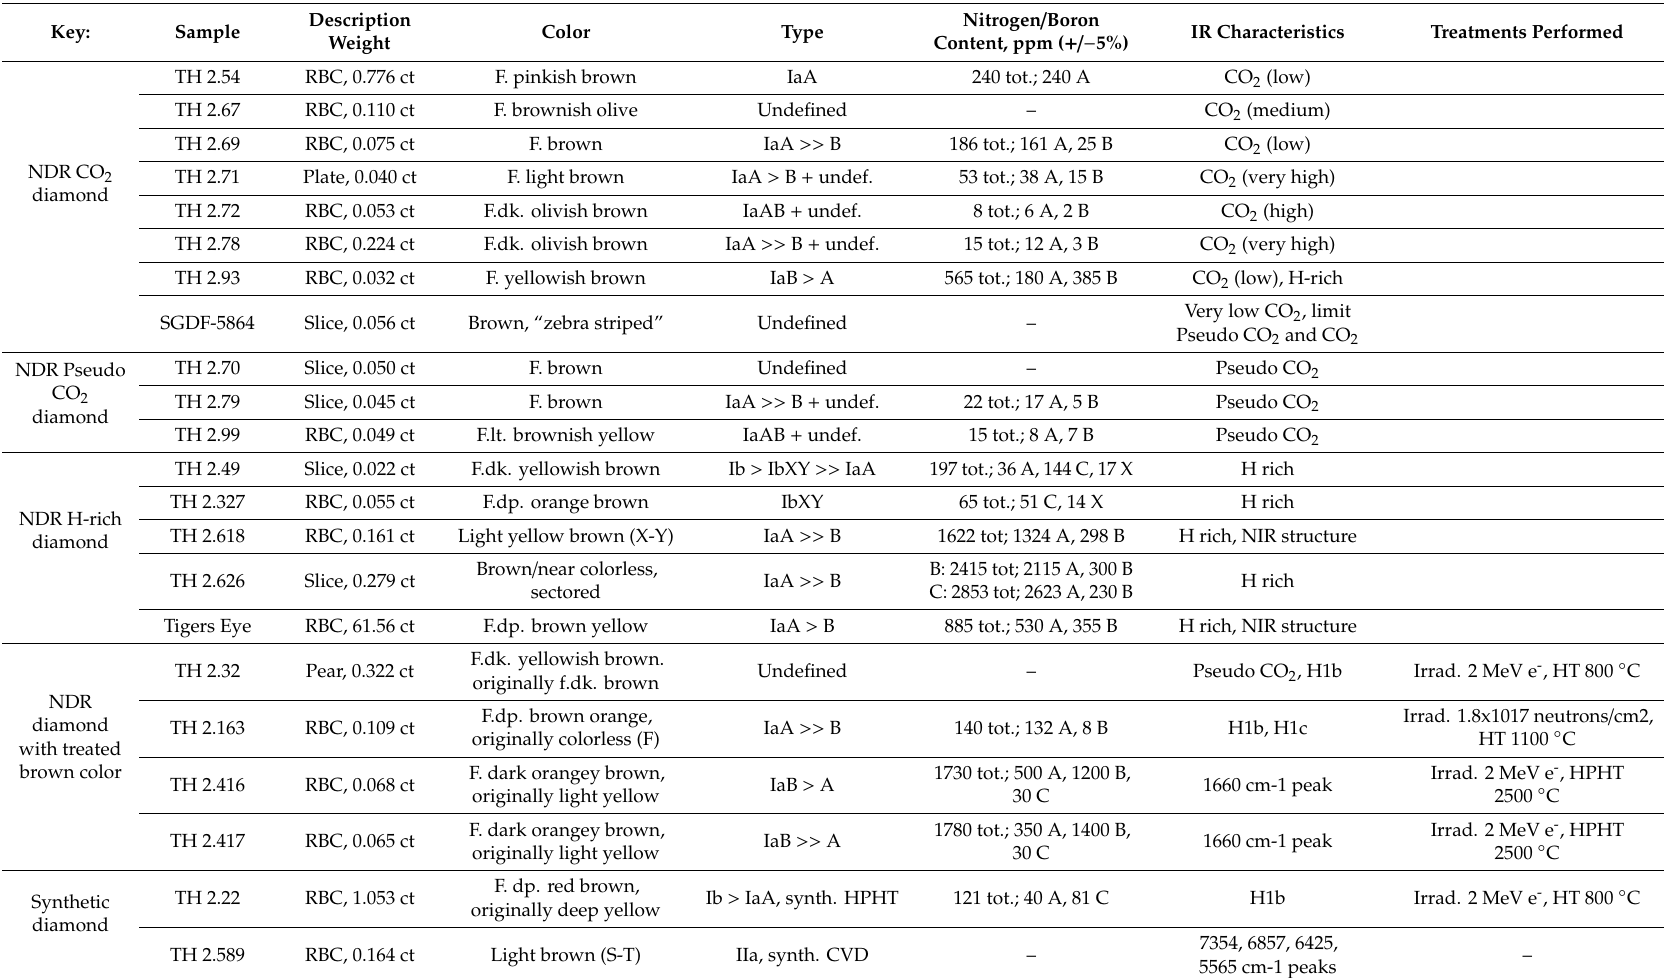
Table 1. An overview of the samples studied with some of their basic optical and infrared spectroscopic